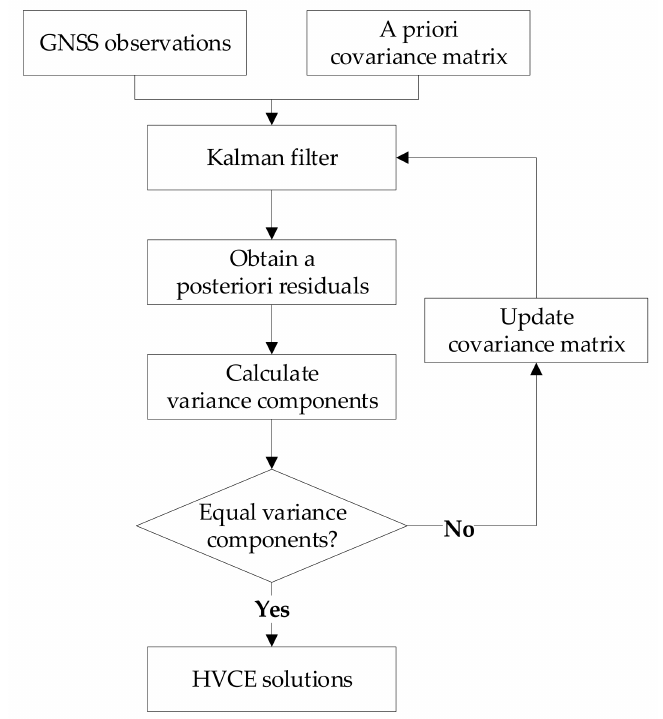
Figure 1. Flow chart of the HVCE method for Kalman